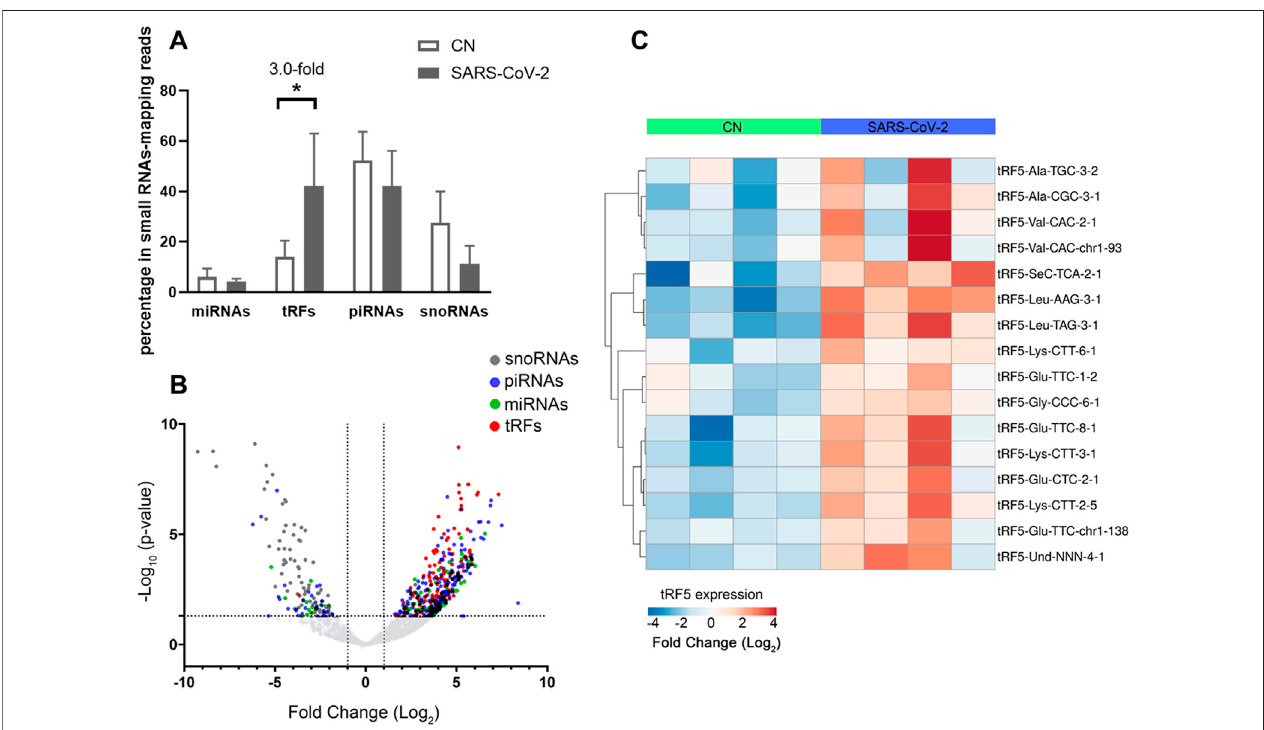
FIGURE 2 | Impacted sncRNAs by SARS-CoV-2 infection in patients. (A) The relative sequencing frequency of miRNAs, tRFs, piRNAs, and snoRNAs was calculated by normalizing their raw reads with the DEseq2 median ratio method. (B) The volcano plot showed that sncRNAs were differentially expressed between and control group (CN) and SARS-CoV-2 patient group (SARS-COV-2). (C) Heatmap for unsupervised clustering of the differently expressed tRFs with > 20 mean of normalized counts in any groups according to Pearson correlation. Data are shown as means ± standard error (SE). The single asterisk represents p values of <